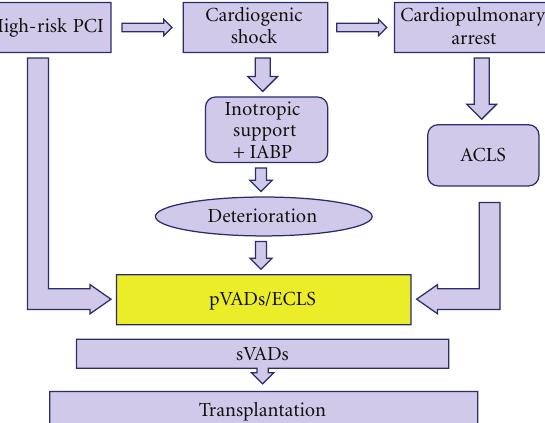
Figure 3: Schematic clinical uses of percutaneous ventricular assist devices (VAD). PCI: percutaneous coronary intervention, ACLS: acute cardiac life support, IABP: intra-aortic balloon pump, pVAD: percutaneous ventricular assist device, sVAD: surgical ventricular assist device, ECLS: extracorporeal life support. Utility of pVADs stretches from prophylactic use in high-risk PCI to immediate life-saving implantation during cardiopulmonary arrest. In cardiogenic shock especially after myocardial infarction, clinical assessment is necessary and current guidelines favour inotropic support with IABP counterpulsation. pVAD or ECLS implantation completes the management when then patient deteriorates . In case of further decline one should think of sVAD as well as heart transplantation.